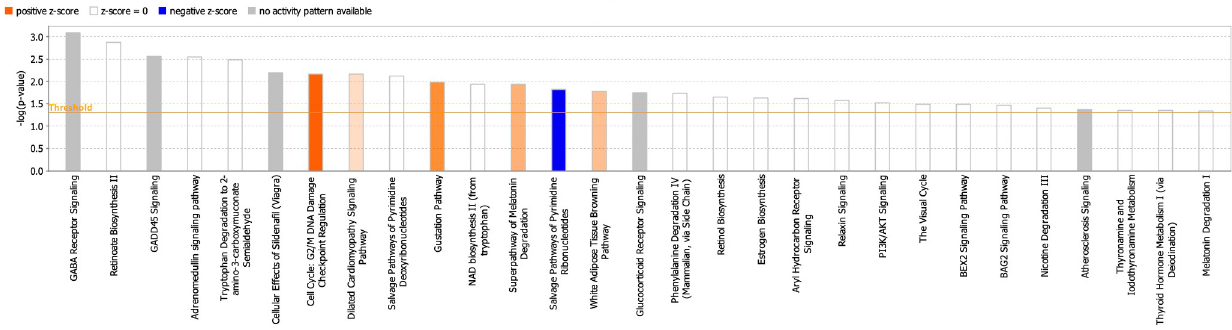
Fig 7. The canonical pathways identified by IPA are based on the DEGs in MOL-treated hWJMSCs. The filter criteria employed is − log (p-value) > 1.3, and the orange line denotes the p-value threshold. Significance was calculated by IPA using Fischer’s exact test, where taller bars indicate increased significance. The bars are coloured according to IPA’s predicted activity status for that particular pathway using the z-score where orange shows activation (z > 2), blue shows inhibition (z < -2) and grey means no available activity